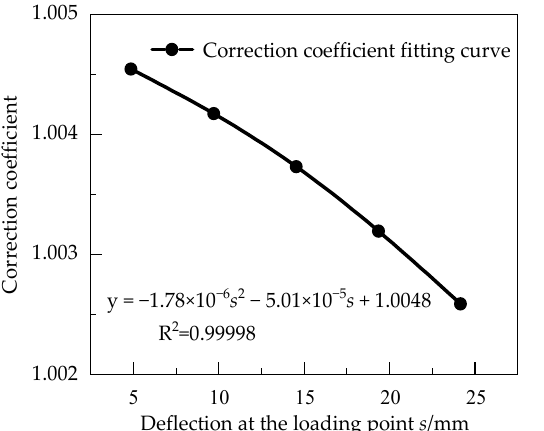
Figure 4. Correction coefficient fitting curves for different deflections at the loading point.